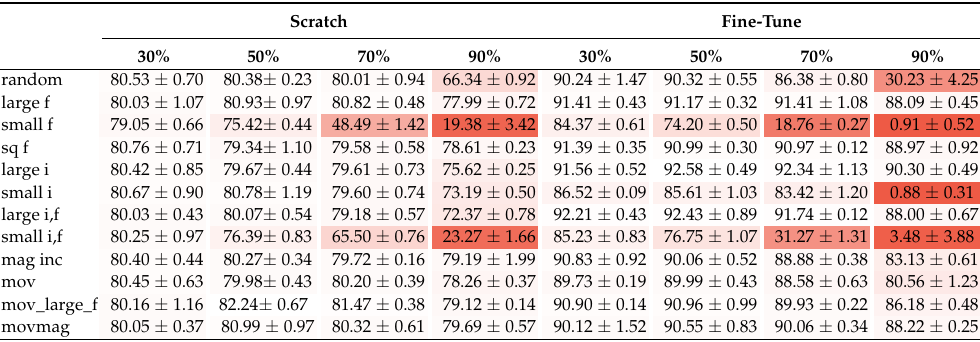
Table 3. Results of sparsifying ResNet-18 for all available criteria. Granularity, context and schedule are respectively set to weight, local and one_cycle. Mean and standard deviation of accuracy over 3 rounds are reported. The darker the shade of red, the further the accuracy is from the baseline.